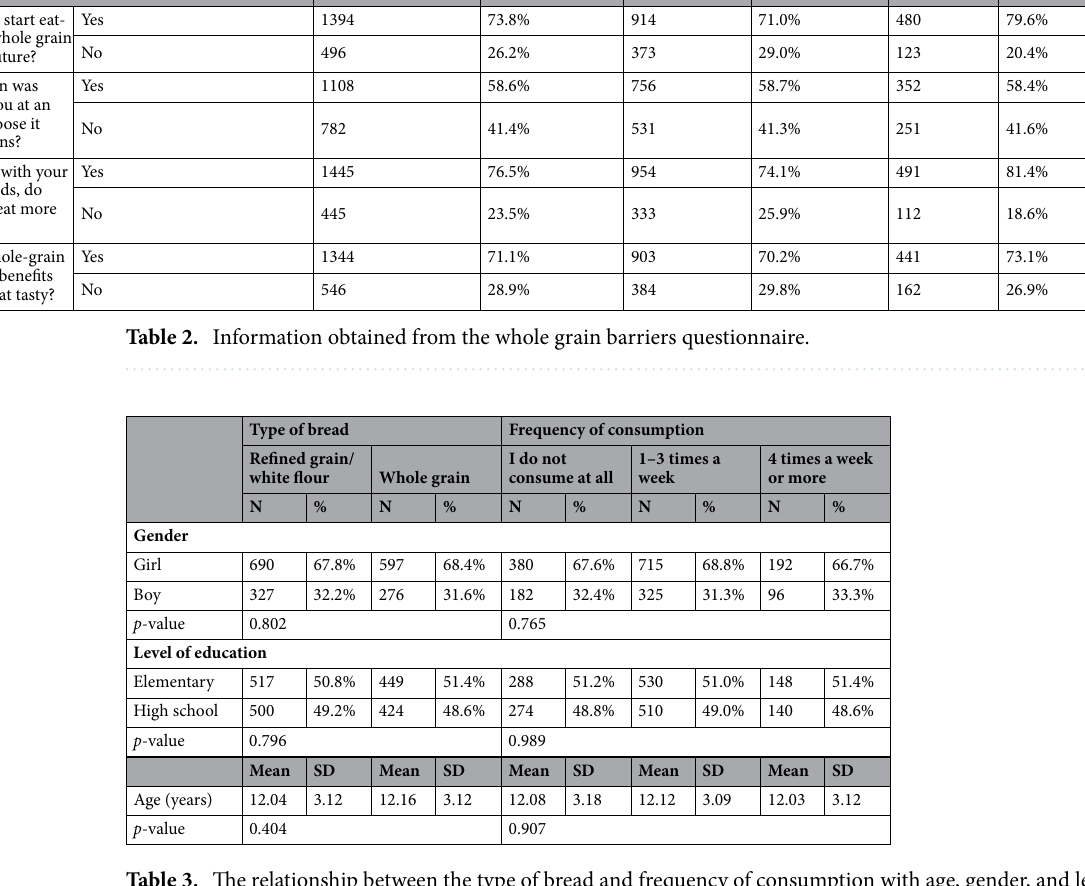
Table 3. The relationship between the type of bread and frequency of consumption with age, gender, and level of education in the